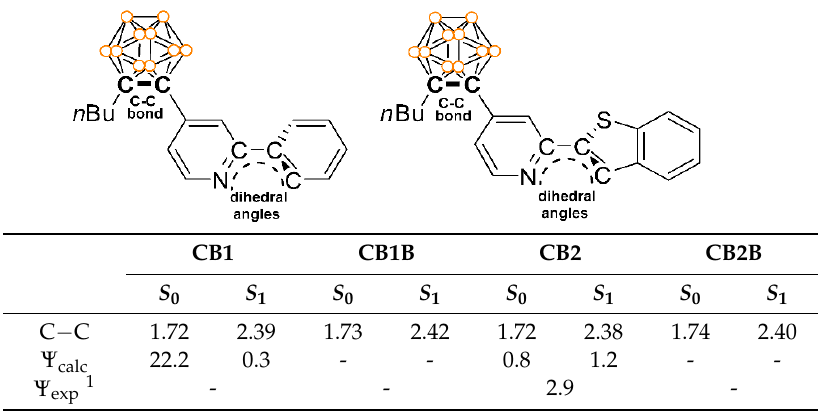
Table 2. C − C bond length (Å) and N − C − C − C dihedral angle ( Ψ , ◦ ) between aromatic rings (curved dotted lines in figure) in the optimized ground ( S 0 ) and first excited singlet state ( S 1 ) structures of Molecules 2018 , 23 , x FOR PEER o -carboranyl compounds